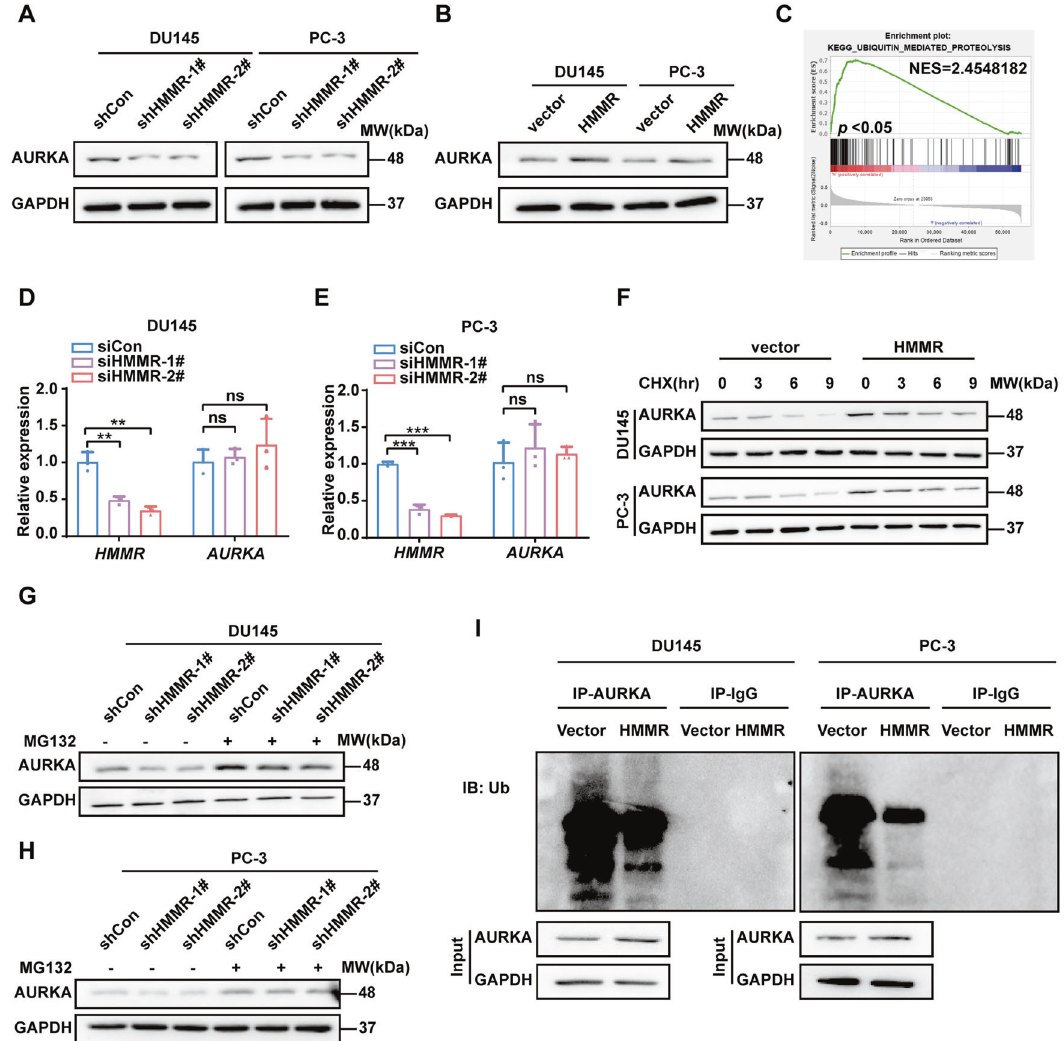
Fig. 5 HMMR evaluated AURKA through inhibiting ubiquitination of AURKA. A , B Western blotting analysis of AURKA after HMMR knockdown ( A ) or overexpression ( B ). C GSEA analysis of the pathway in which HMMR might be involved. D , E qRT – PCR analysis of AURKA mRNA after transfecting siHMMR (#1, #2) or negative control in DU145 ( D ) and PC-3 ( E ) cells. F Western blotting analysis of AURKA levels after treating cells (vector and HMMR) with CHX at 0, 3, 6, and 9 h to assess the degradation ratio of AURKA. CHX concentration: 50 μ g/ml, left panel: DU145, right panel: PC-3. GAPDH was used as a loading control. G Western blotting analysis of AURKA levels after treating DU145 (upper) and PC-3 (lower) cells with HMMR silencing or negative control cells with or without MG132; MG132 concentration: 100 nM. H Western blotting analysis of AURKA ubiquitination in HMMR-overexpressing or control cells. Whole-cell lysates were puri fi ed with anti-AURKA and then immunoprecipitated with anti-ubiquitin antibody, anti-IgG was used as a negative control. Data were presented as mean ± SD. ** p < 0.01, *** p < 0.001, ns not signi fi